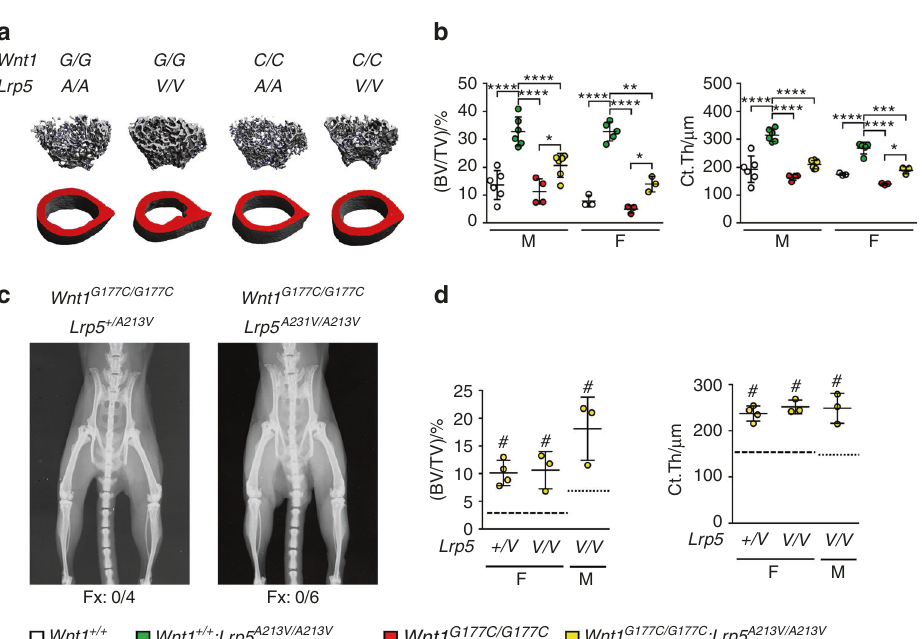
Fig. 5 Assessment of osteoanabolic treatment options in Wnt1 G177C/G177C mice. a Representative µCT images of the distal femoral trabecular (top) and cortical (bottom) bone of 12-week-old wild-type ( + / + ; + / + ), Lrp5 A213V/A213V ( + / + ; A/A ), Wnt1 G177C/G177C ( G/G ; + / + ) and Lrp5 A213V/A213V / Wnt1 G177C/G177C ( G/G ; A/A ) mice. b Quanti fi cation of the trabecular bone volume and cortical thickness in male and female mice. Data were analyzed by two-way ANOVA with Sidak ’ s multiple comparison test (* P < 0.05, ** P < 0.01, *** P < 0.001, **** P < 0.000 1). c Representative contact radiographs of 24-week-old Wnt1 G177C/G177C mice carrying one or two Lrp5 A213V alleles. The number below the radiographs indicates the number of animals with fractures (Fx) per total number of animals in the group. d Quanti fi cation of the trabecular bone volume and cortical thickness in the femur of 24-week-old Wnt1 G177C/G177C mice of the indicated sex and Lrp5 genotype. The dashed lines indicate the respective values in Wnt1 G177C/G177C mice with two wild-type Lrp5 alleles. Data were analyzed by Student ’ s t -test (mutant Lrp5 alleles vs. two wild-type Lrp5 alleles, # P < 0.05). Error bars indicate standard